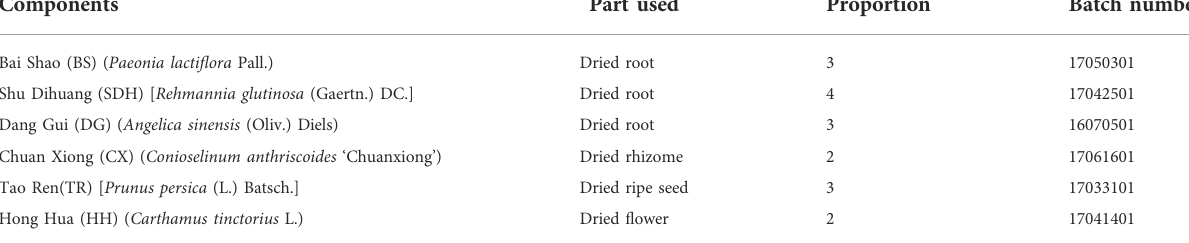
TABLE 1 Constituents of THSWD. Components Part